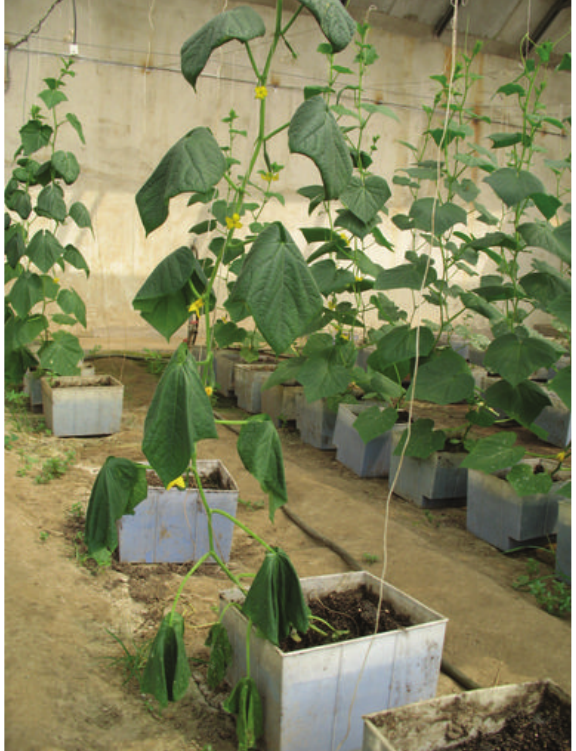
Figure 5: Photo of a real wilting cucumber in greenhouse.